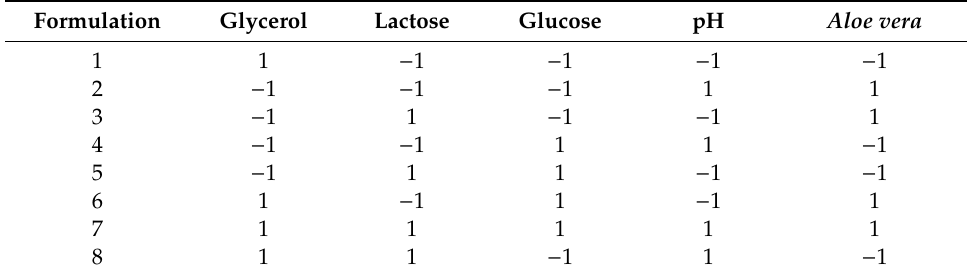
Table 2. A quarter fraction 2 5–2 experimental design was used to investigate the e ff ect of factors influencing the viability and antifungal capacity of films containing the TEP6 strain. Formulation Glycerol